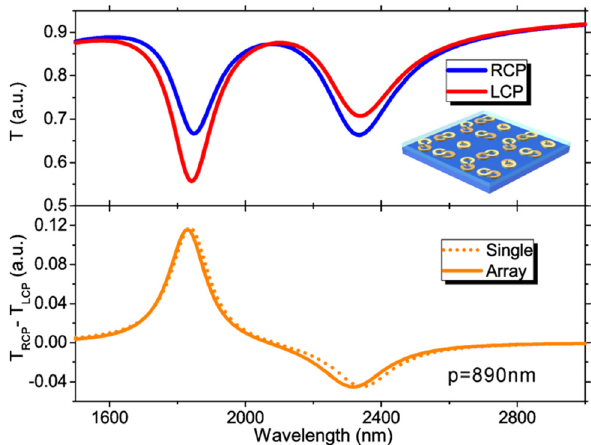
Figure 5: CD responses related to the magnetic dipole resonance of the stereo-SRR dimer array shown in Figure 3. Upper panel: transmission spectra under RCP (blue lines) and LCP (red lines) incidences; Lower panel: corresponding transmission CD spectrum for the dimer array (solid line) and the CD spectrum calculated for an ensemble of uncoupled single dimers ( Δ T = 4 × Δ Abs/ p 2 , dotted